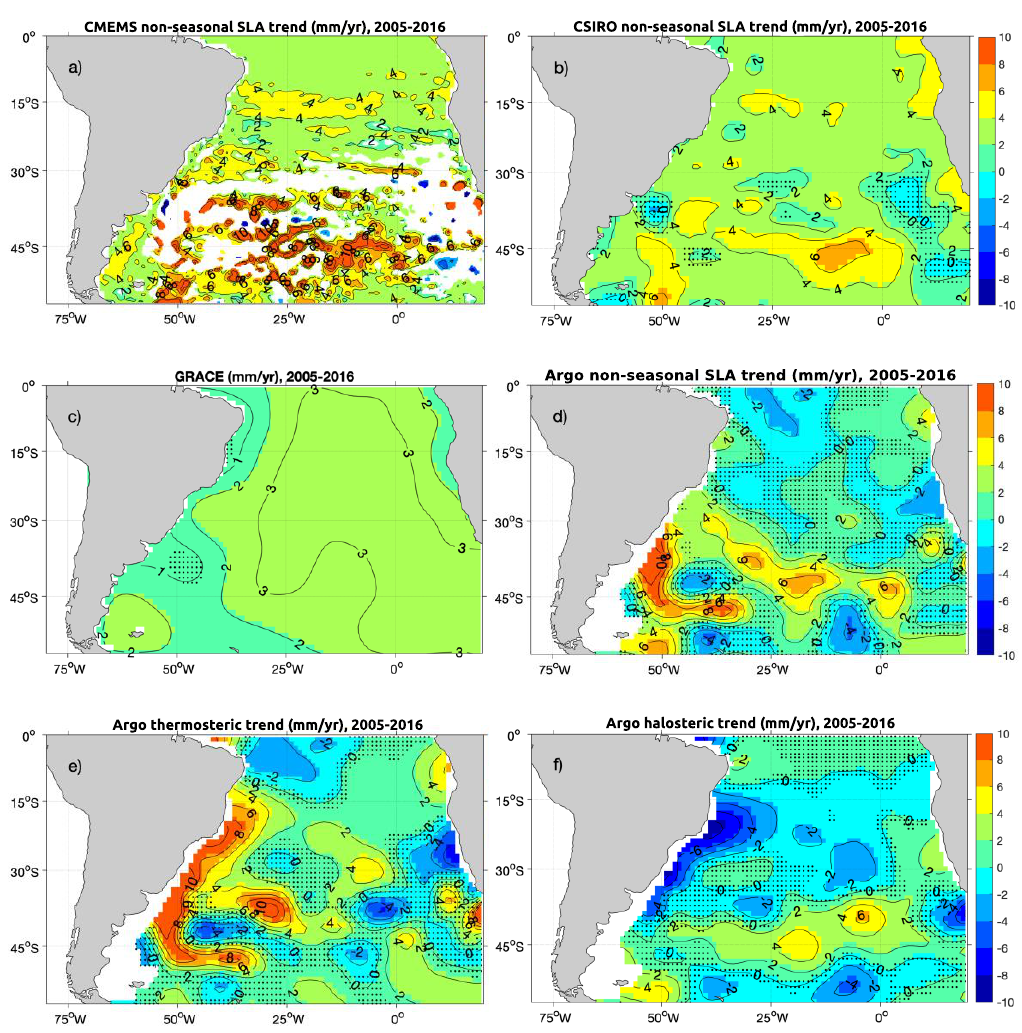
Figure 8. Sea level trend spatial pattern derived from ( a ) CMEMS, ( b ) CSIRO, ( c ) GRACE (mean of JPL, GFZ and CSR), ( d ) Argo (steric height), ( e ) thermosteric height (Argo) and ( f ) halosteric height (Argo). The white area in panel ( a ) and the black dots in the panels ( b – f ) represent the non-significant trends. Units: mm/yr.